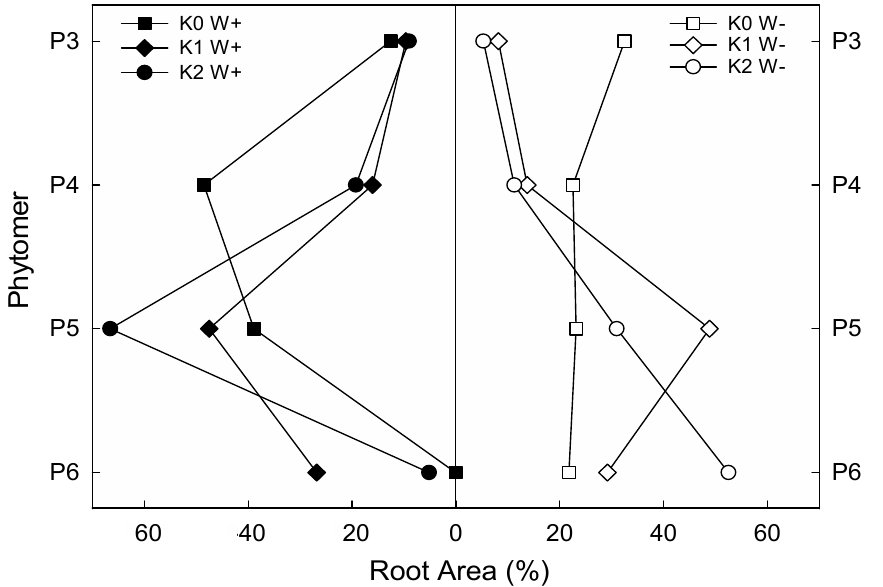
Figure 4. Distribution of root area (%) by phytomer for well-watered (W+, black symbols) and water stressed (W − , white symbols) corn plants grown at three different levels of potassium (K0 = low, K1 = normal, K2 = high; mean; n = 2). A phytomer consists in a repetition of constructional units represented by successive horizontal circles from which roots emerge at the base of the stem (labelled from P1 at the bottom to P6 at the top).